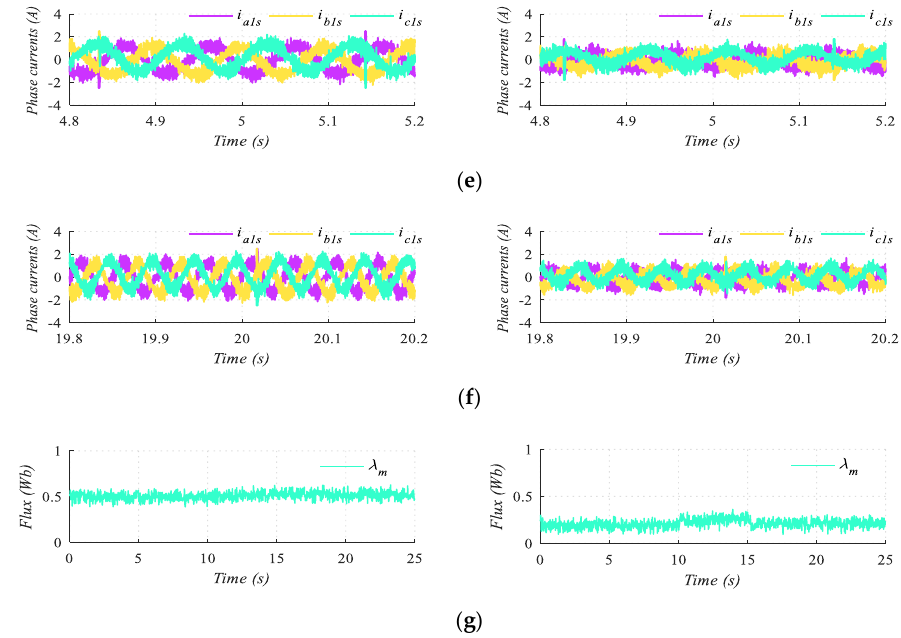
Figure 7. Pre-fault evaluation of the proposed VV-MPC technique (left column) versus EVV-MPC method (right column). From top to bottom: ( a ) Motor speed; ( b ) 𝑑 - 𝑞 currents; ( c ) the difference between 𝑞 - and 𝑑 -current; ( d ) 𝑥 - 𝑦 currents; ( e ) zoom 1 of set 1 of phase currents; ( f ) zoom 1 of set 2 of phase currents; and ( g ) stator magnetic flux.